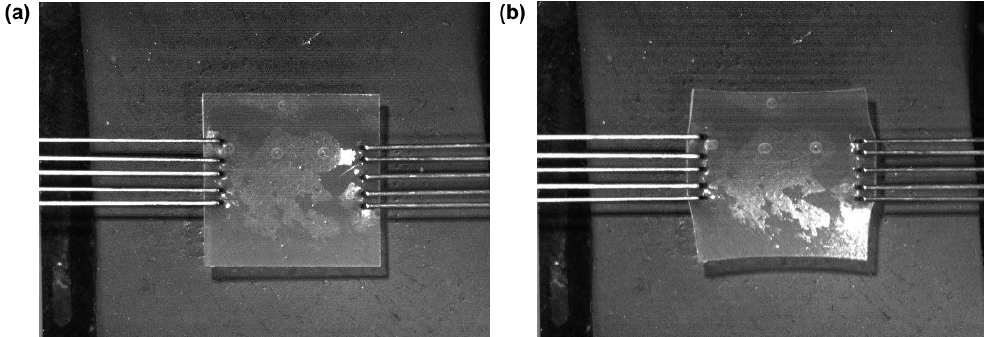
Figure 2. Illustration of sample setup within the CellScale BioTester. ( a ) The setup before any stress is applied; ( b ) at the end of the test after stress has been applied and deformation can clearly be seen.